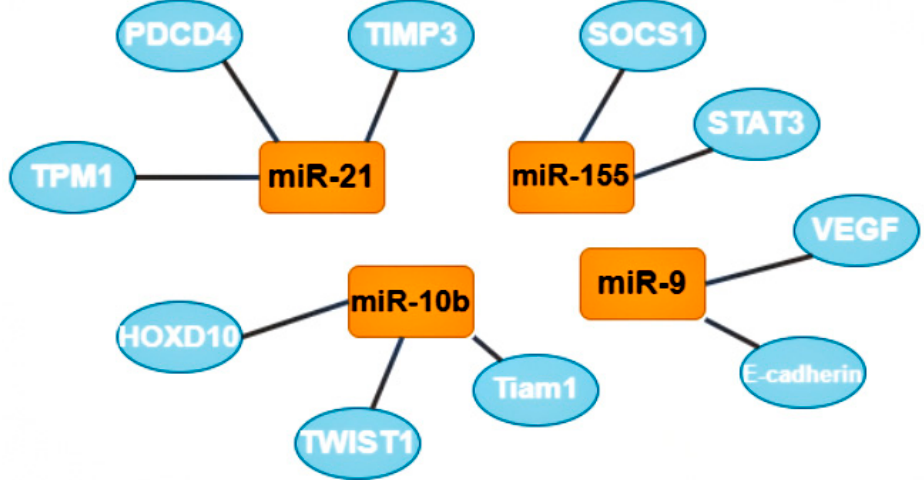
Figure 4. The most studied oncomirs and their target genes. MiR-21 has 3 common target genes: tropomyosin 1 (TPM1), programmed cell death 4 (PDCD4), and metallopeptidase inhibitor 3 (TIMP3). MiR-10b also has 3 target genes, including homeobox D10 (HOXD10), twist-related protein 1 (TWIST1) and T cell lymphoma invasion and metastasis-inducing protein 1 (Tiam 1). Mir-9 target genes are vascular endothelial growth factors (VEGF) and E-cadherin (also known as CDH1). MiR-155 has 2 target genes: suppressor of cytokine signaling 1 (SOCS1) and signal transducer and activator of transcription 3 (STAT3).